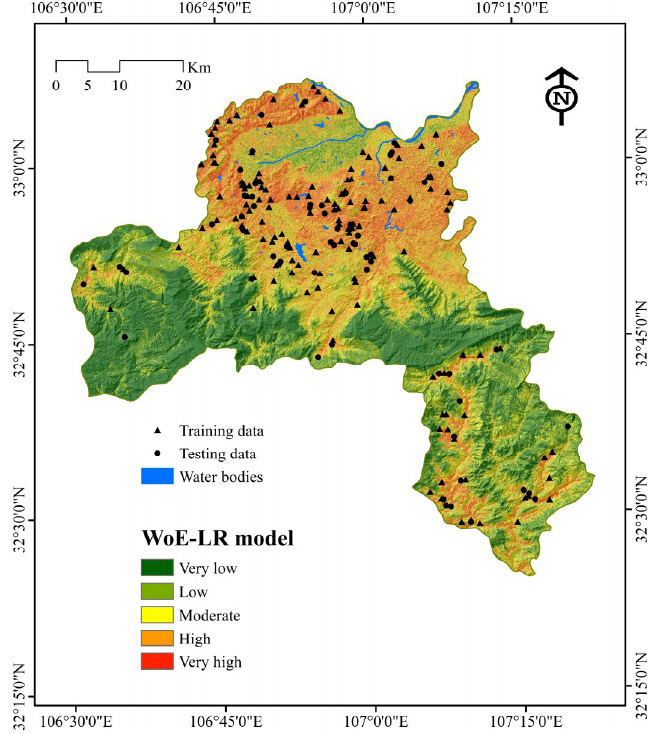
Figure 5. Landslide susceptibility map using the WoE-LR model.